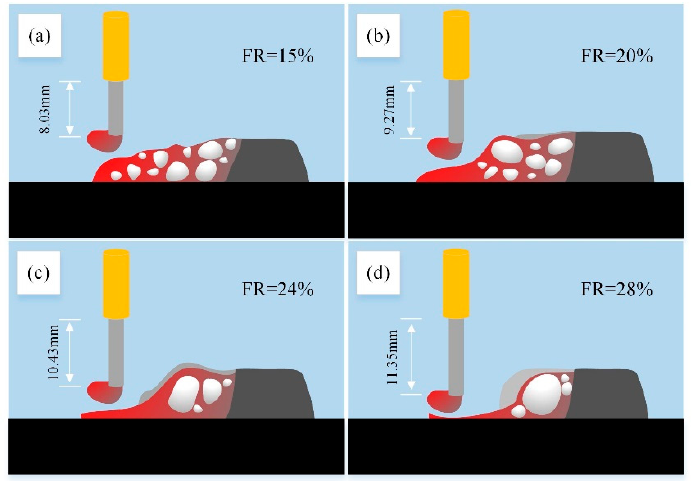
ff erent filling